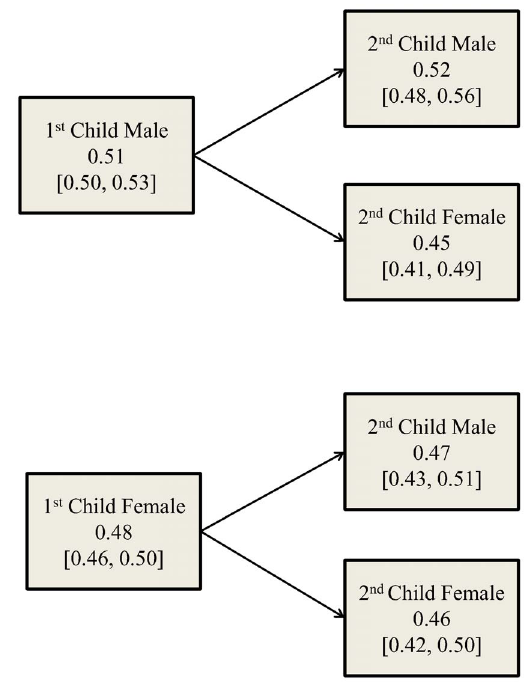
Figure 3. Predicted probabilities of receiving breast milk, children , 60 months,